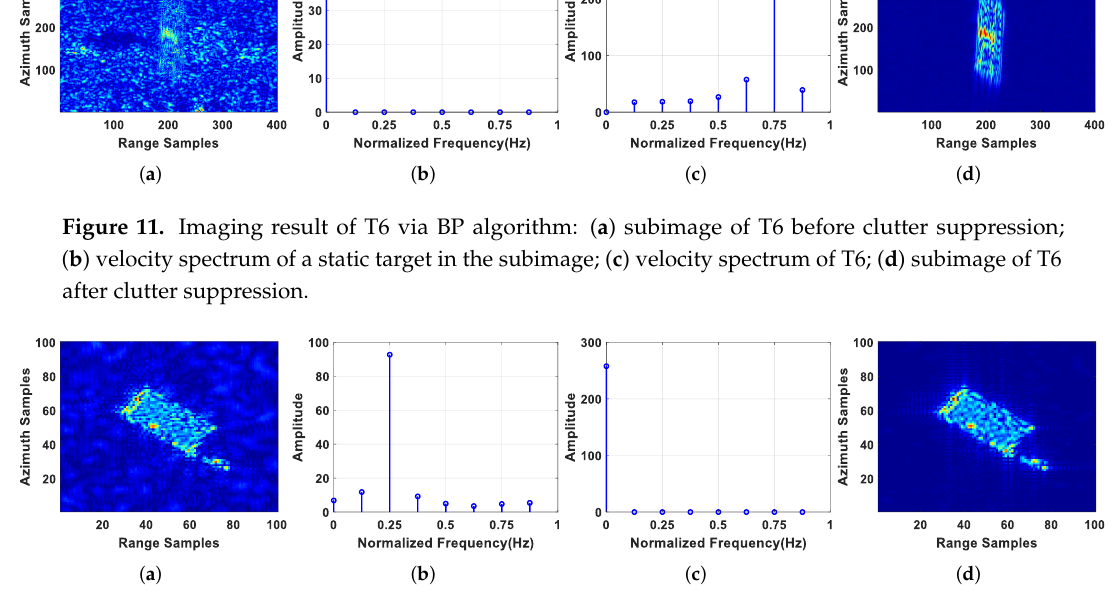
Figure 12. Imaging result of T6 via VA-BP algorithm: ( a ) subimage of T6 before clutter suppression; ( b ) velocity spectrum of a static target in the subimage; ( c ) velocity spectrum of T6; ( d ) subimage of T6 after clutter